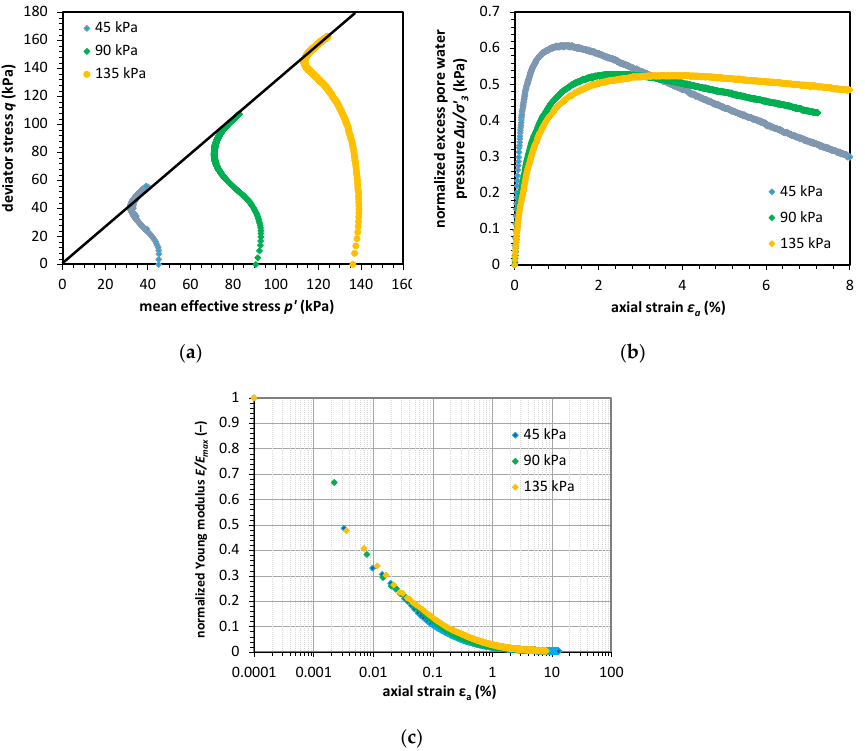
Figure 6. Results of the static triaxial tests on silty sandy clay samples, stress paths ( a ), normalized pore water pressure characteristics ( b ), and normalized Young modulus characteristics ( c ).